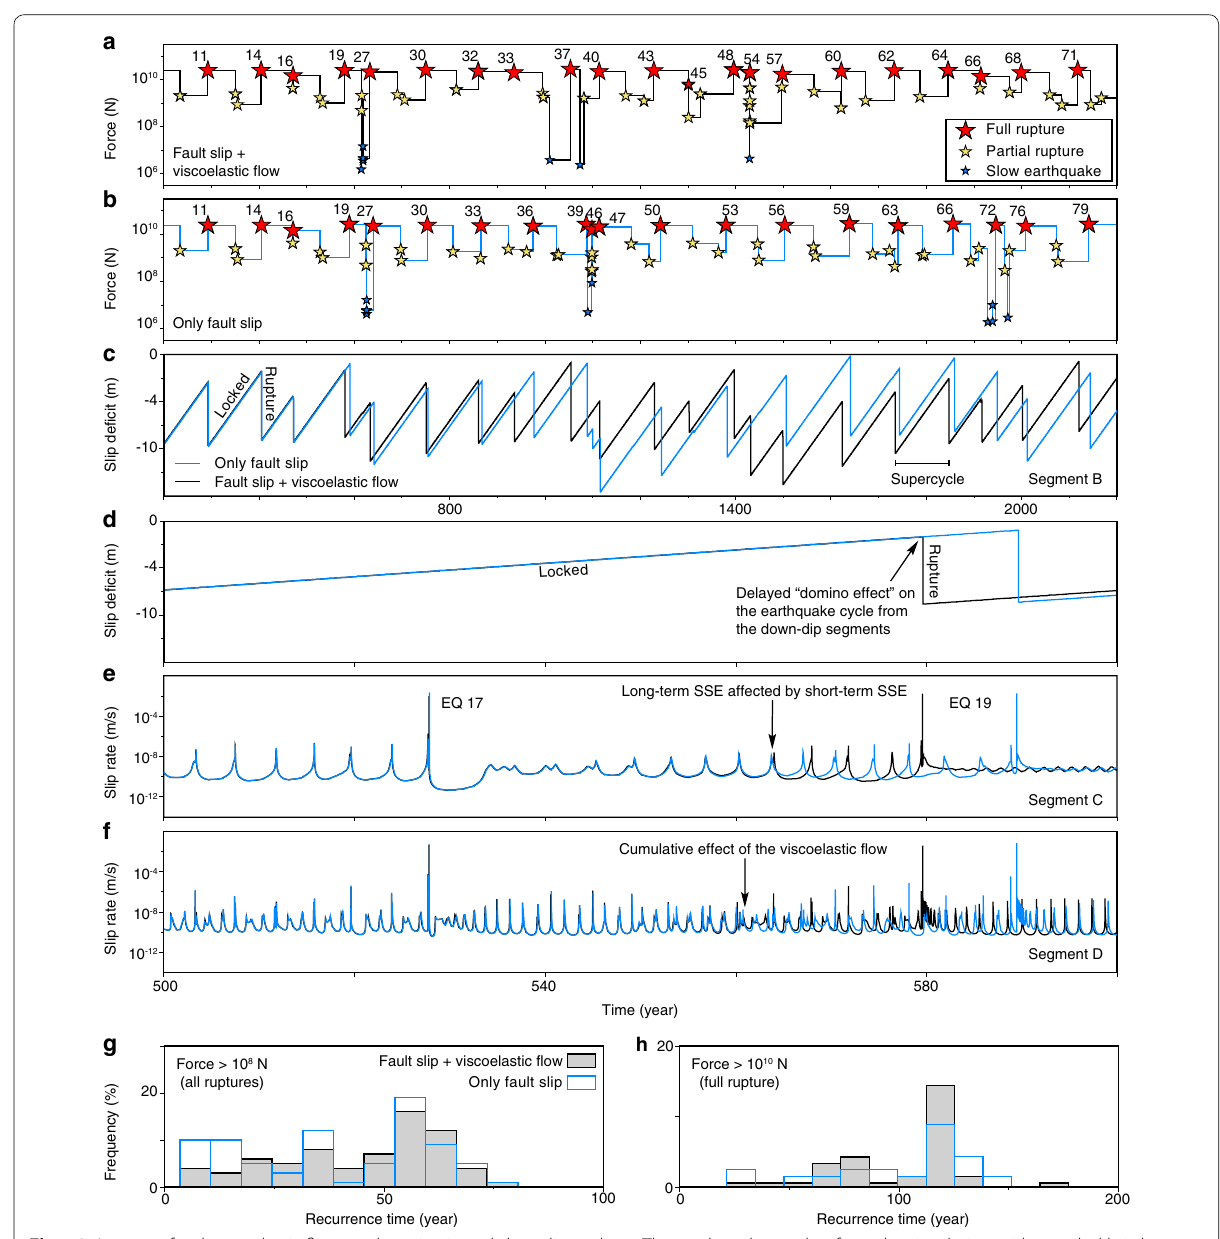
Fig. 10 Impact of asthenospheric flow on the seismic and slow-slip cycles. a The earthquake catalog from the simulation with coupled brittle and ductile deformation. Great earthquakes (red stars with event numbers) corresponding to full rupture of the seismogenic zone are connected by black lines with partial ruptures (orange stars) and slow earthquakes (yellow stars) in order of occurrence. b The earthquake catalog from the simulation with only brittle deformation along the megathrust segments. Events are connected by a blue line. c Slip deficit (black and blue for models with and without viscoelastic flow, respectively) at the center of the seismogenic zone (segment B). Earthquake recurrence time starts to be modulated by viscoelastic flow after several super-cycles (about 560 years). a – c share the same x -axis. d The enlarged view of earthquake cycles of the time period between 500 and 600 years in c . e and f share the same x-axis as d . e Effect of viscoelastic flow on long-term slow-slip events. f Effect of asthenosphere flow on short-term slow-slip events. g Distribution of recurrence times for earthquakes with force larger than 10 8 N (all ruptures) with (gray) our without (blue) coupling with viscoelastic flow. h Distribution of recurrence time of great earthquakes with force larger than 10 10 N (only full